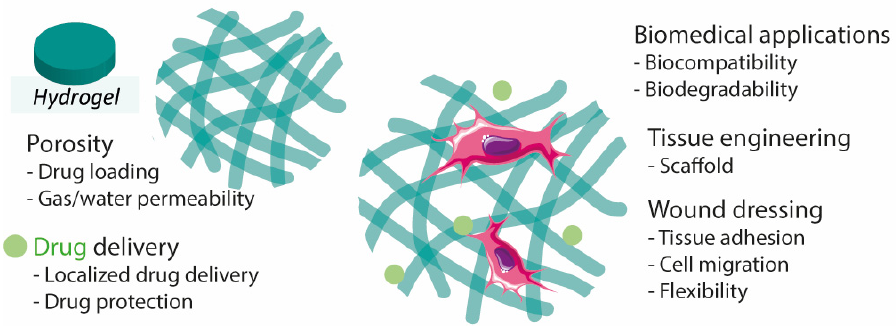
Figure 2. Hydrogel characteristics for wound healing, drug delivery, and tissue engineering.